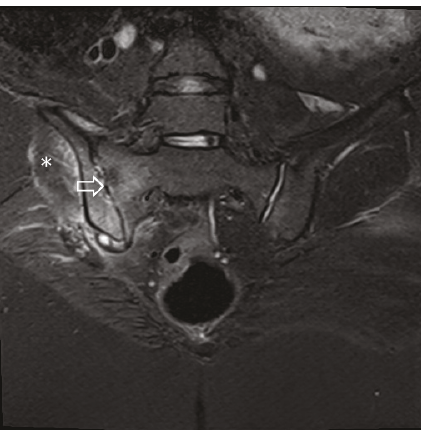
Figure 1: MRI images of right sacroiliac junction and sacroiliitis are shown by the arrow. Edema of right psoas muscle is shown by asterisk.